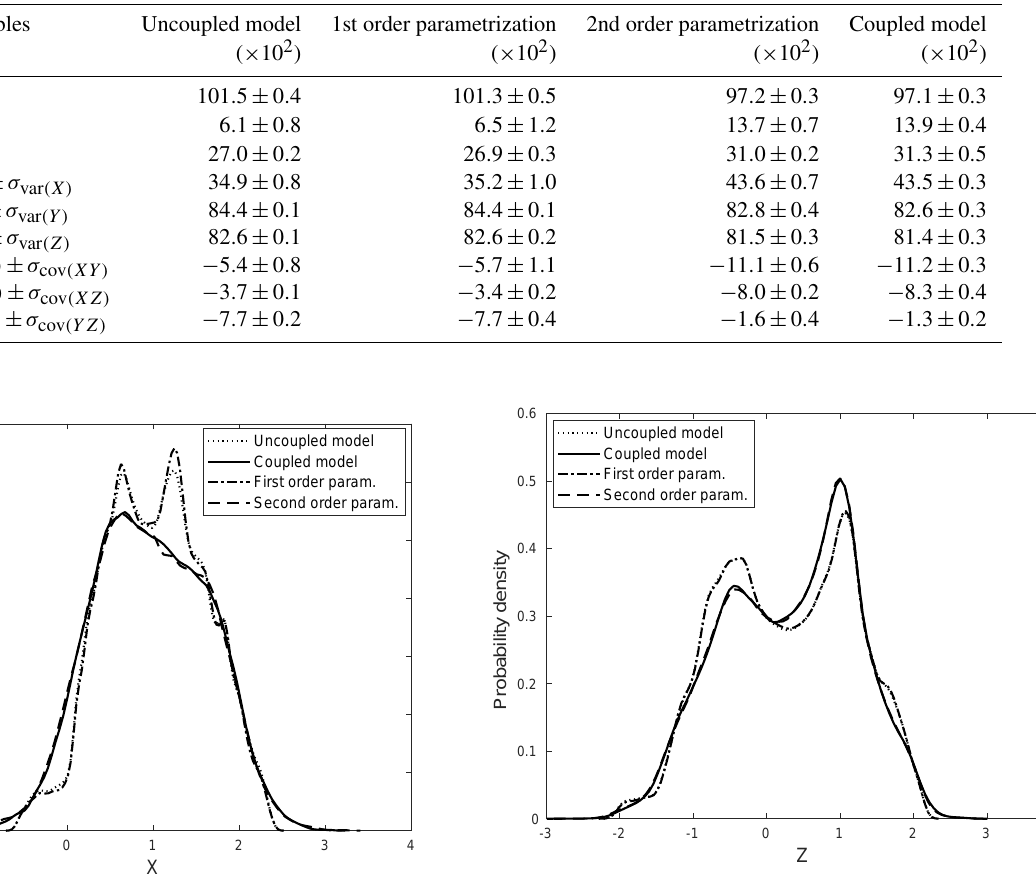
Figure 6. Probability density of the Z variable. For case τ = 5, the Lorenz 63 model acts as a fast forcing on the Lorenz 84